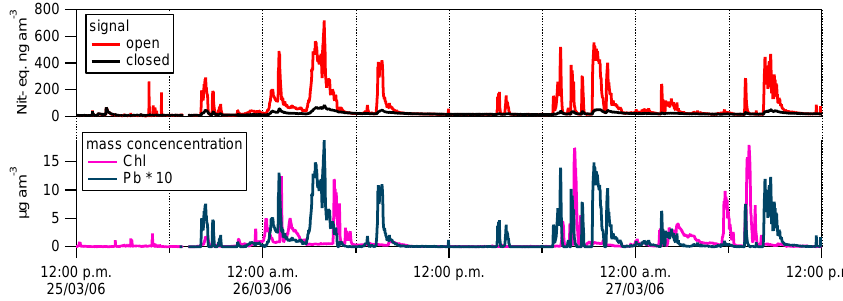
Fig. 15. Top panel: Time series of C-AMS Pb open and closed signals at the PEMEX site. Bottom panel: Mass concentration of Pb compared with particle Chloride at the same